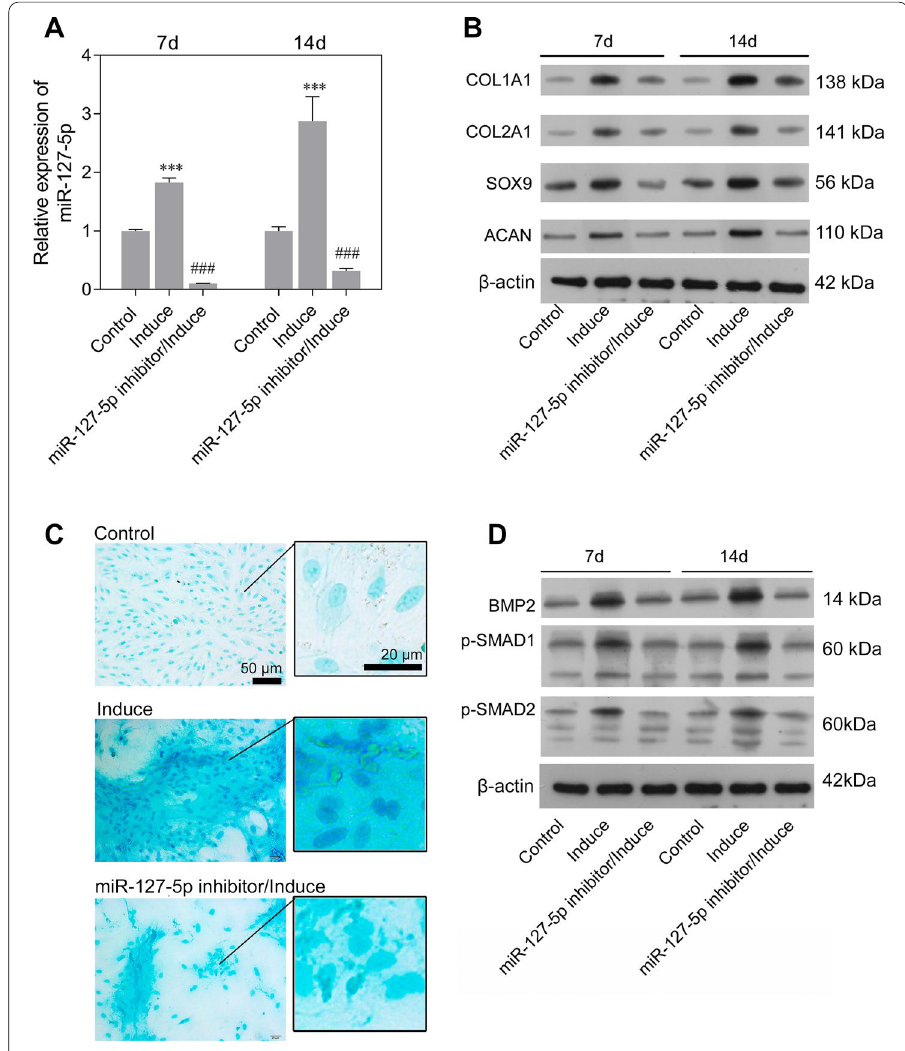
Fig. 3 Downregulation of miR-127-5p suppressed chondrogenic differentiation of rMSCs via SMAD-dependent BMP signaling. The rMSCs were transfected with an miR-127-5p inhibitor, followed by induction of chondrogenic differentiation for 7 and 14 days. A MiR-127-5p expression was determined by quantitative real-time PCR analysis. Results are expressed as mean standard deviation of data obtained from ± three independent experiments. *** p < 0.001, compared with control; ### p < 0.001, compared with induction group; B Levels of COL1A1, COL2A1, SOX9, and ACAN protein expression were detected in rMSCs. C Images from Alcian blue staining assays of rMSCs. D Western blotting was performed to measure the levels of BMP2, p-SMAD1, and p-SMAD2 protein expression in